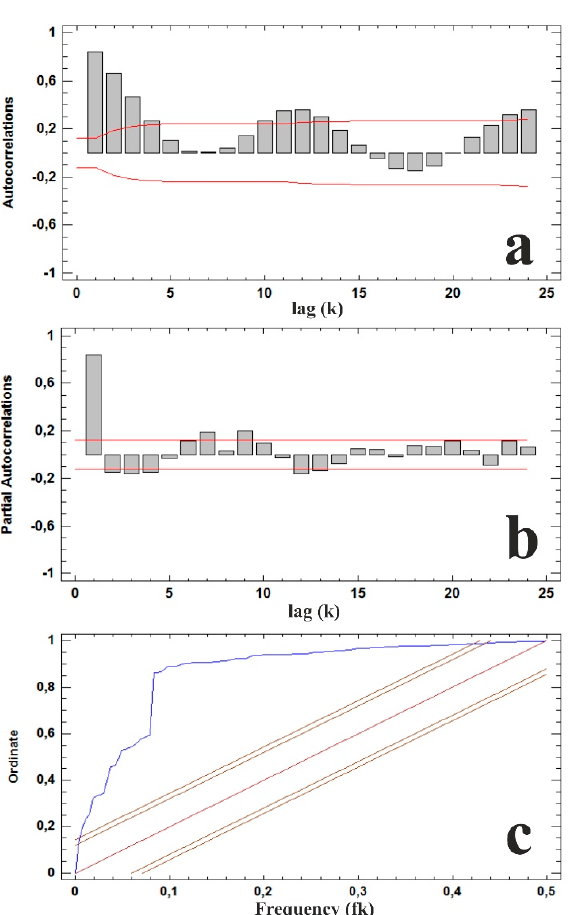
Figure 8. ( a ) Autocorrelation Function (ACF), ( b ) Partial Autocorrelation function (PACF), and ( c ) Cumulative Periodogram [C(f k )] of the logarithmically modified time series data of Kefalovriso spring discharge from 1974 to 1993.